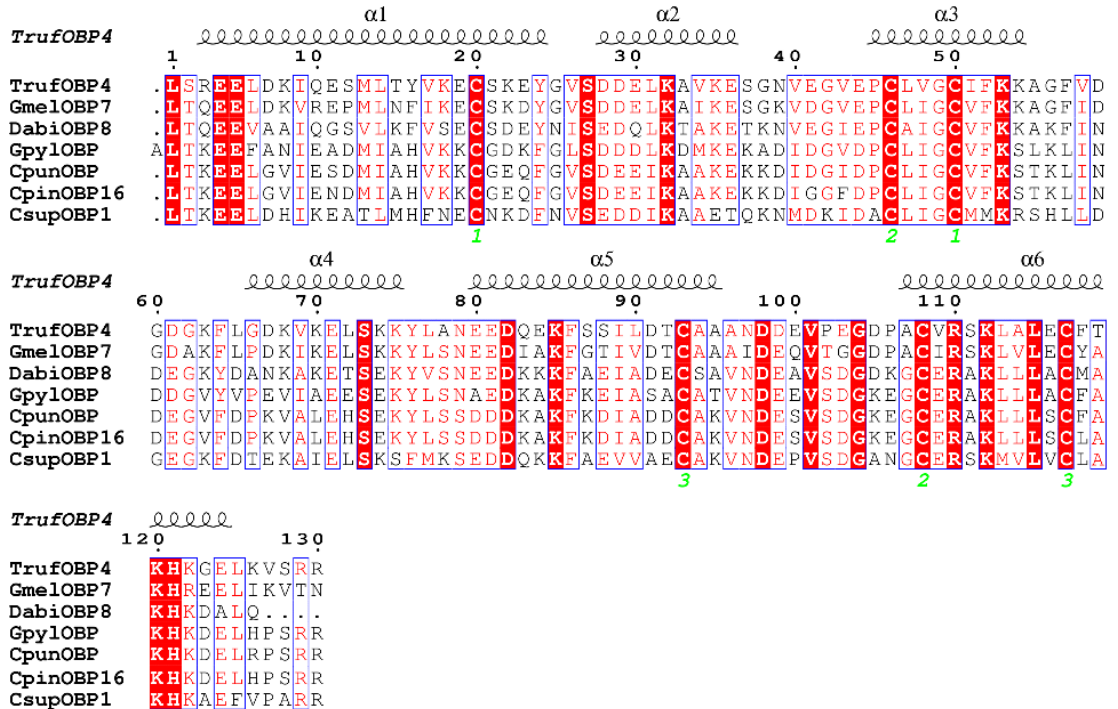
Figure 2. Alignment of TrufOBP4 with OBP genes from other Pyraloidae insect species. Galleria mellonella (Gmel), Dioryctria abietella (Dabi), Glyphodes pyloalis (Gpyl), Conogethes punctiferalis (Cpun), Conogethes pinicolalis (Cpin), and Chilo suppressalis (Csup). The bound cysteines that formed disulfide bridges are marked by green digits at the bottom of sequences.